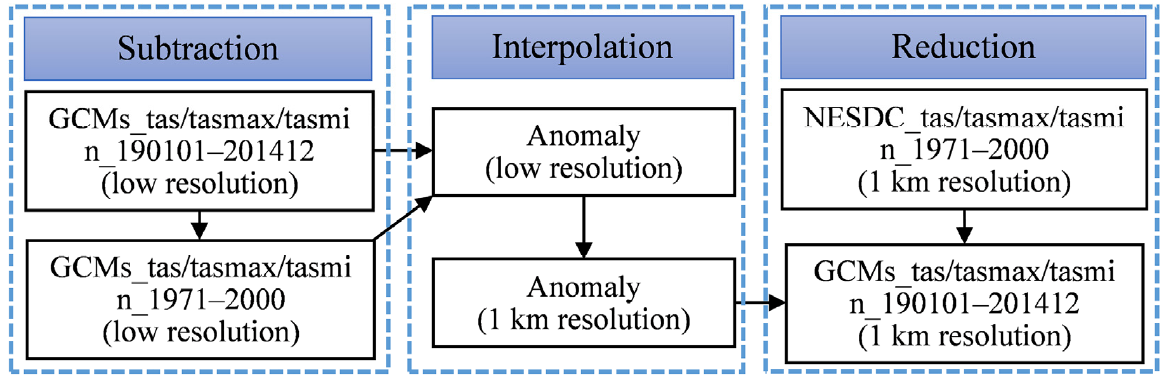
Figure 2. The delta downscaling process of the climate models over the Yellow River Basin.